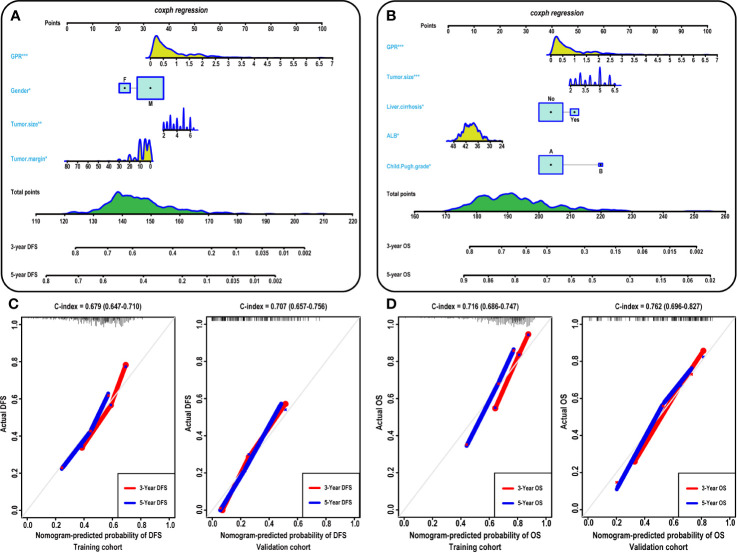
Construction and calibration of the nomogram models. (A–B) Development of the nomogram to predict the 3- and 5-year DFS (A) and OS (B) rates for HCC. Calibration curves showing the predictive accuracy for the 3- and 5-year DFS rates of the HCC patients in the training (C-left) and validation (C-right) cohort. Calibration curves showing the predictive accuracy for the 3- and 5-year OS rates of the HCC patients in the training (D-left) and validation (D-left) cohort. ALB, albumin; GPR, gamma‐glutamyl transpeptidase‐to‐platelet ratio; DFS, disease-free survival; OS, overall survival; HCC, hepatocellular carcinoma.